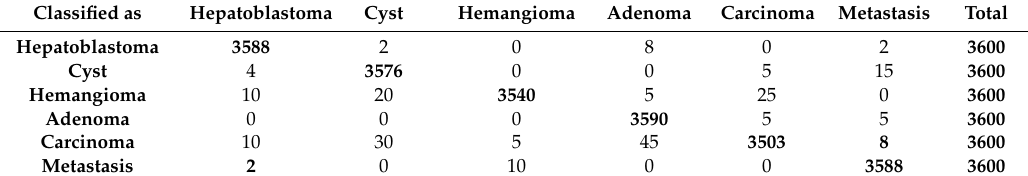
Table 6. Confusion matrix of the fused optimized hybrid-feature dataset using the MLP classifier.